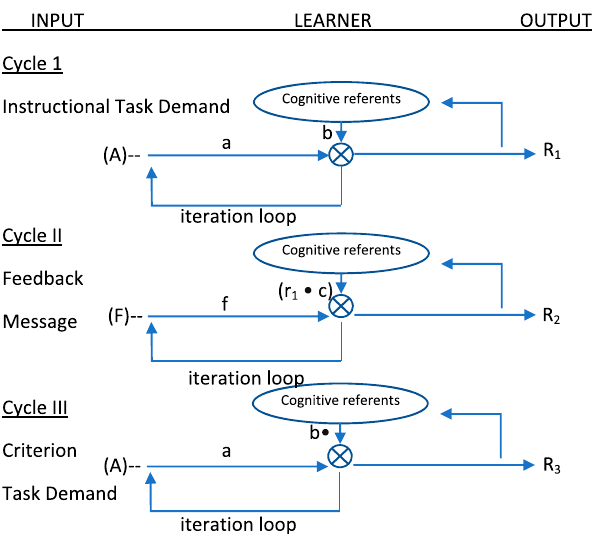
FIGURE 3 | Adapted from Kulhavy and Stock (1989) three-cycle feedback